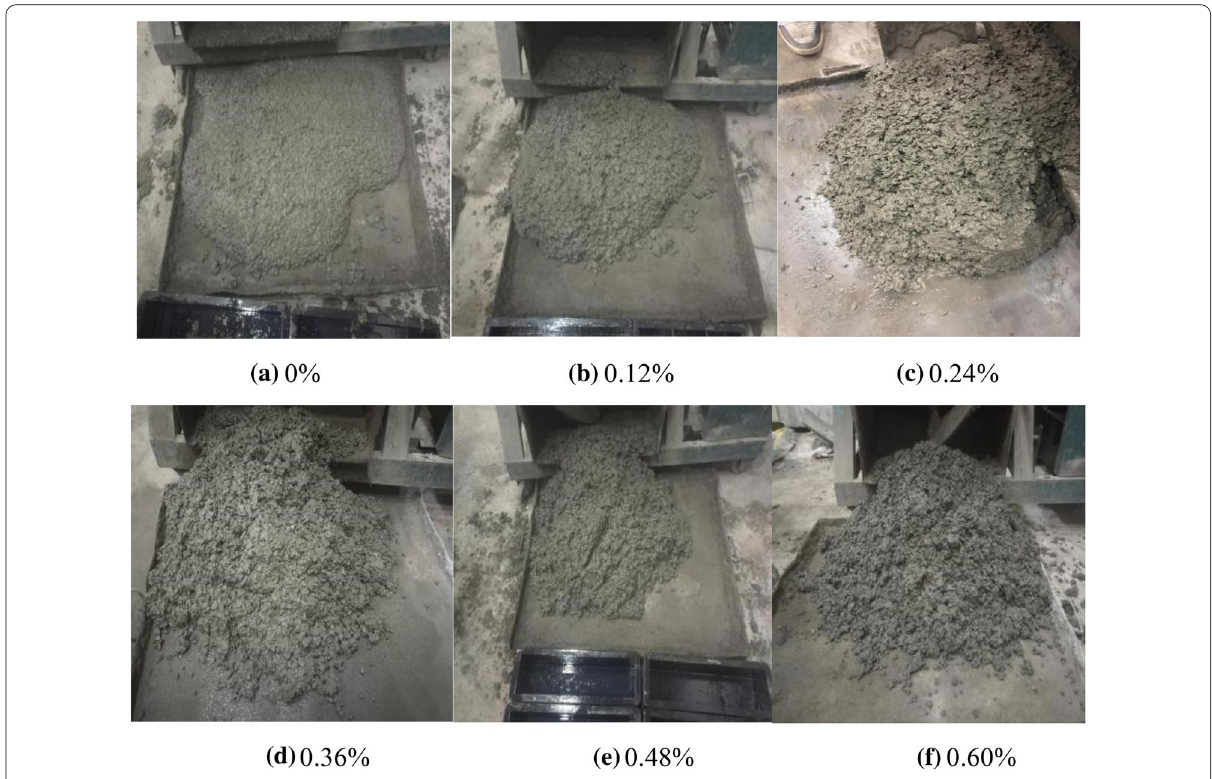
Fig.3 HFRC statuses with different fraction volume. a 0%. b 0.12%. c 0.24%. d 0.36%. e 0.48%. f